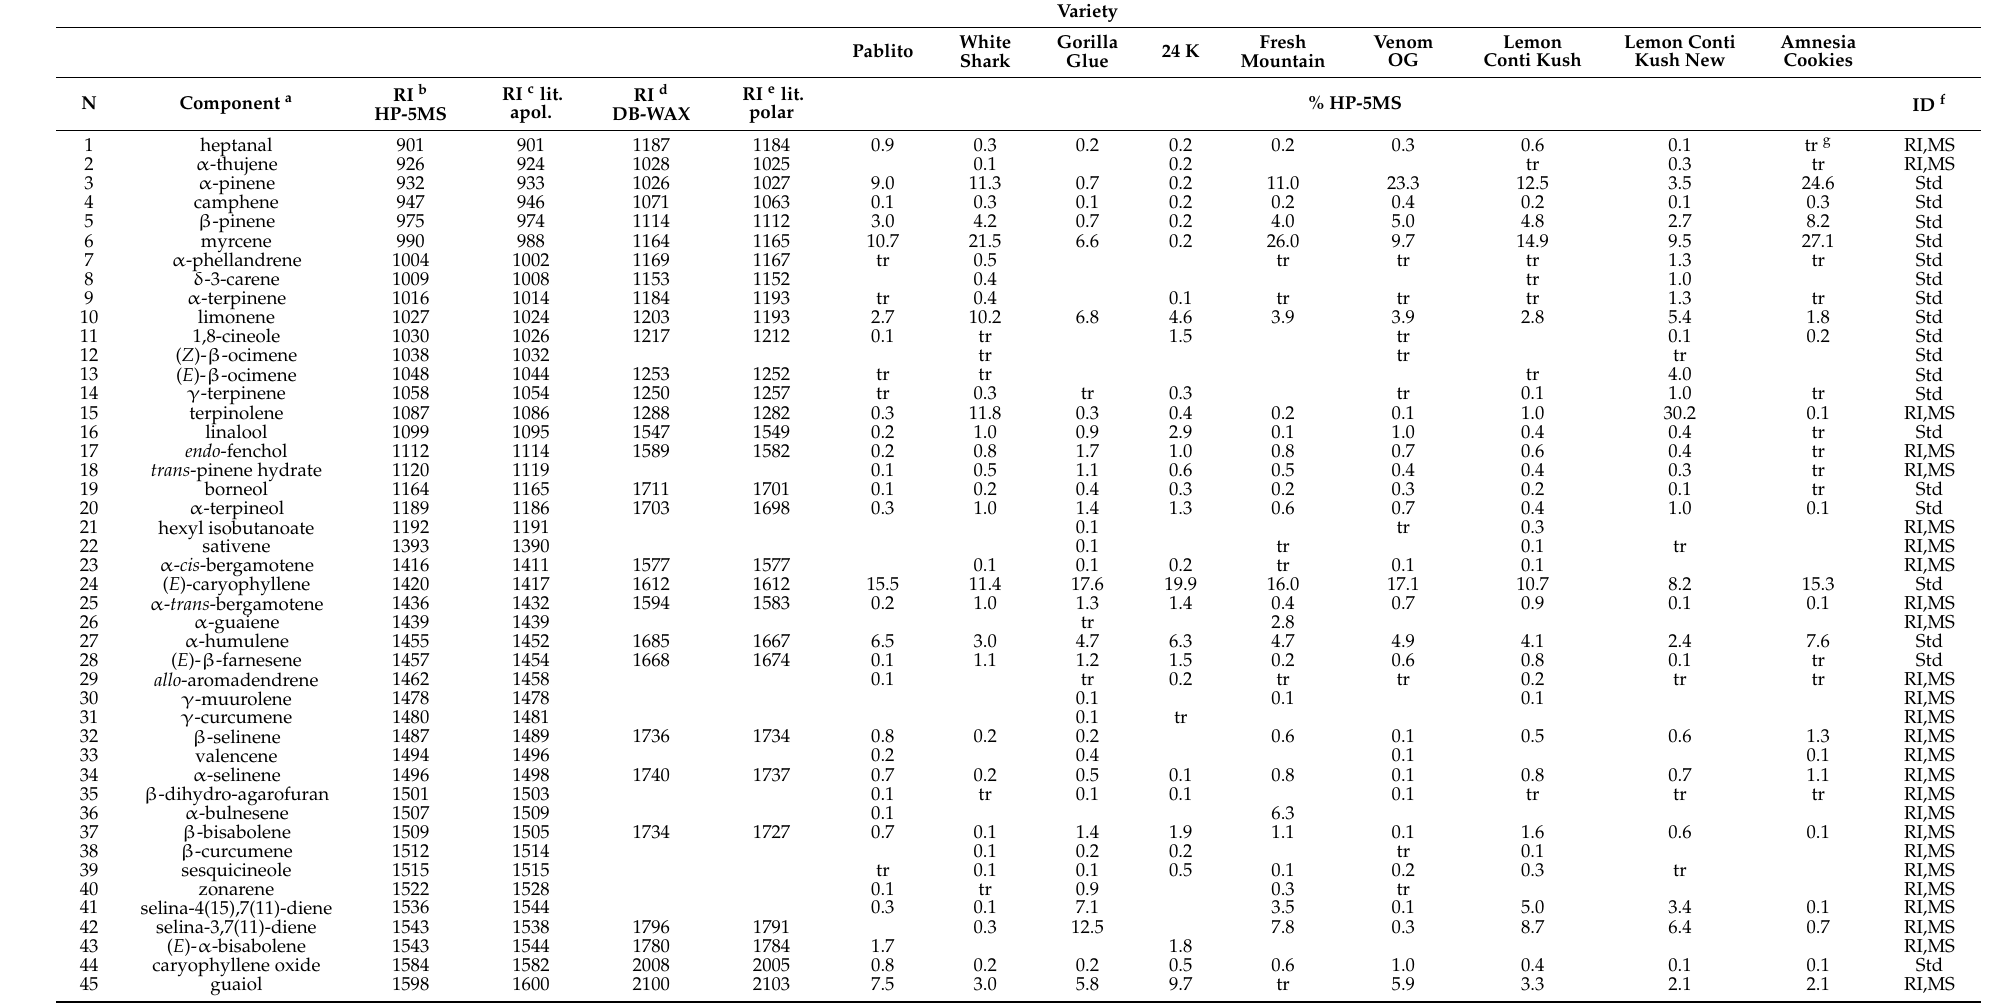
Table 2. GC-MS analysis results for the 9 commercial varieties